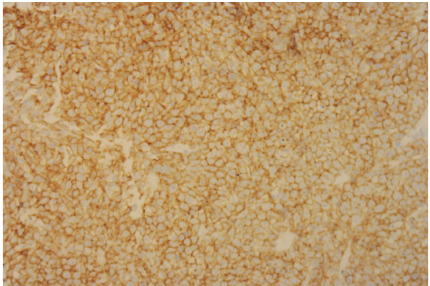
Figure 7: Adrenal gland biopsy showing lymphoid cell positivity for B-cell marker CD20.